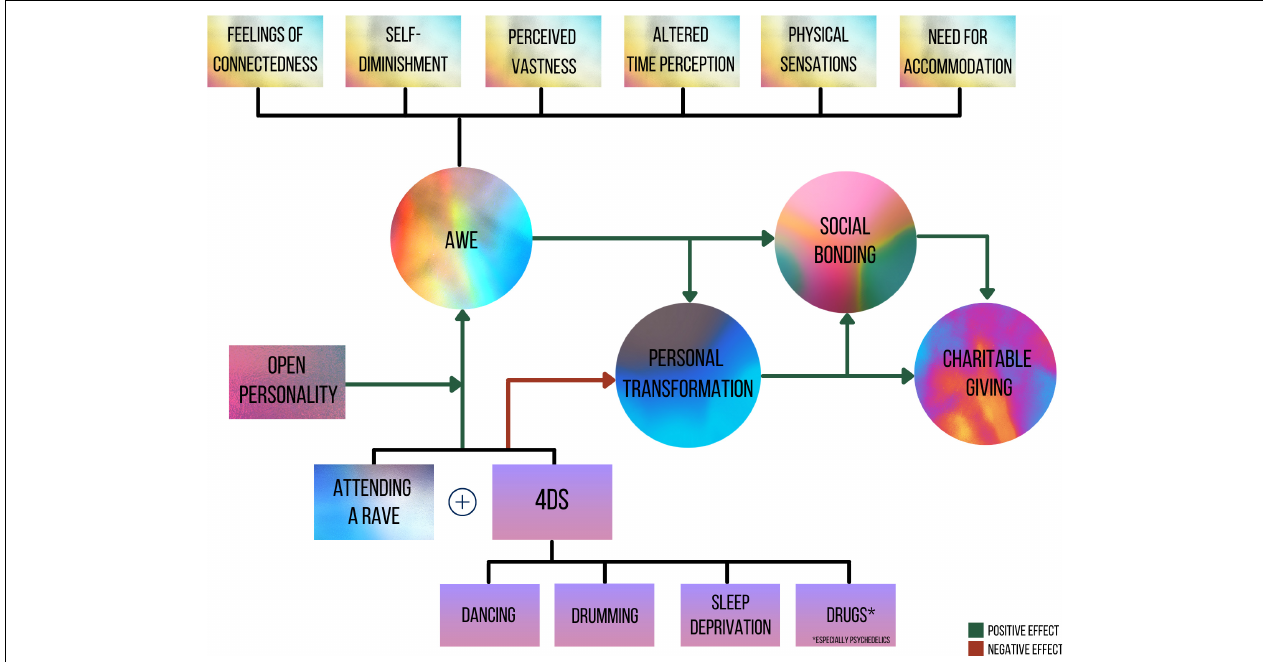
FIGURE 1 | Full model from the 4Ds to prosocial behaviors via awe, transformativeness, and social bonding.